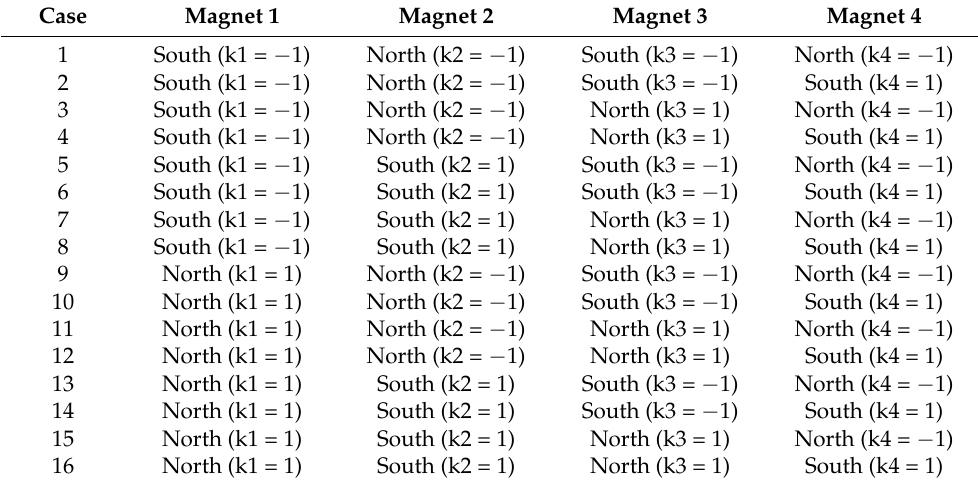
Table 2. Cases for Magnet orientation.